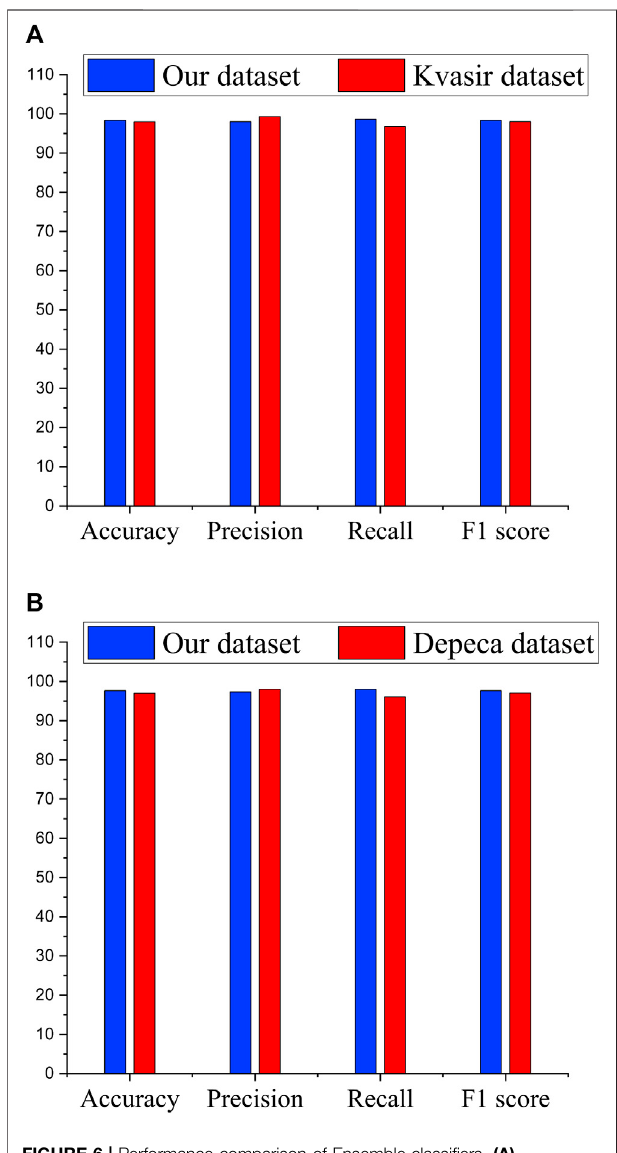
FIGURE 6 | Performance comparison of Ensemble classi fi ers. (A) Performance of Ensemble classi fi er on signi fi cant frame detection. (B) Performance of Ensemble classi fi er on classi fi cation of cancerous and noncancerous polyps.